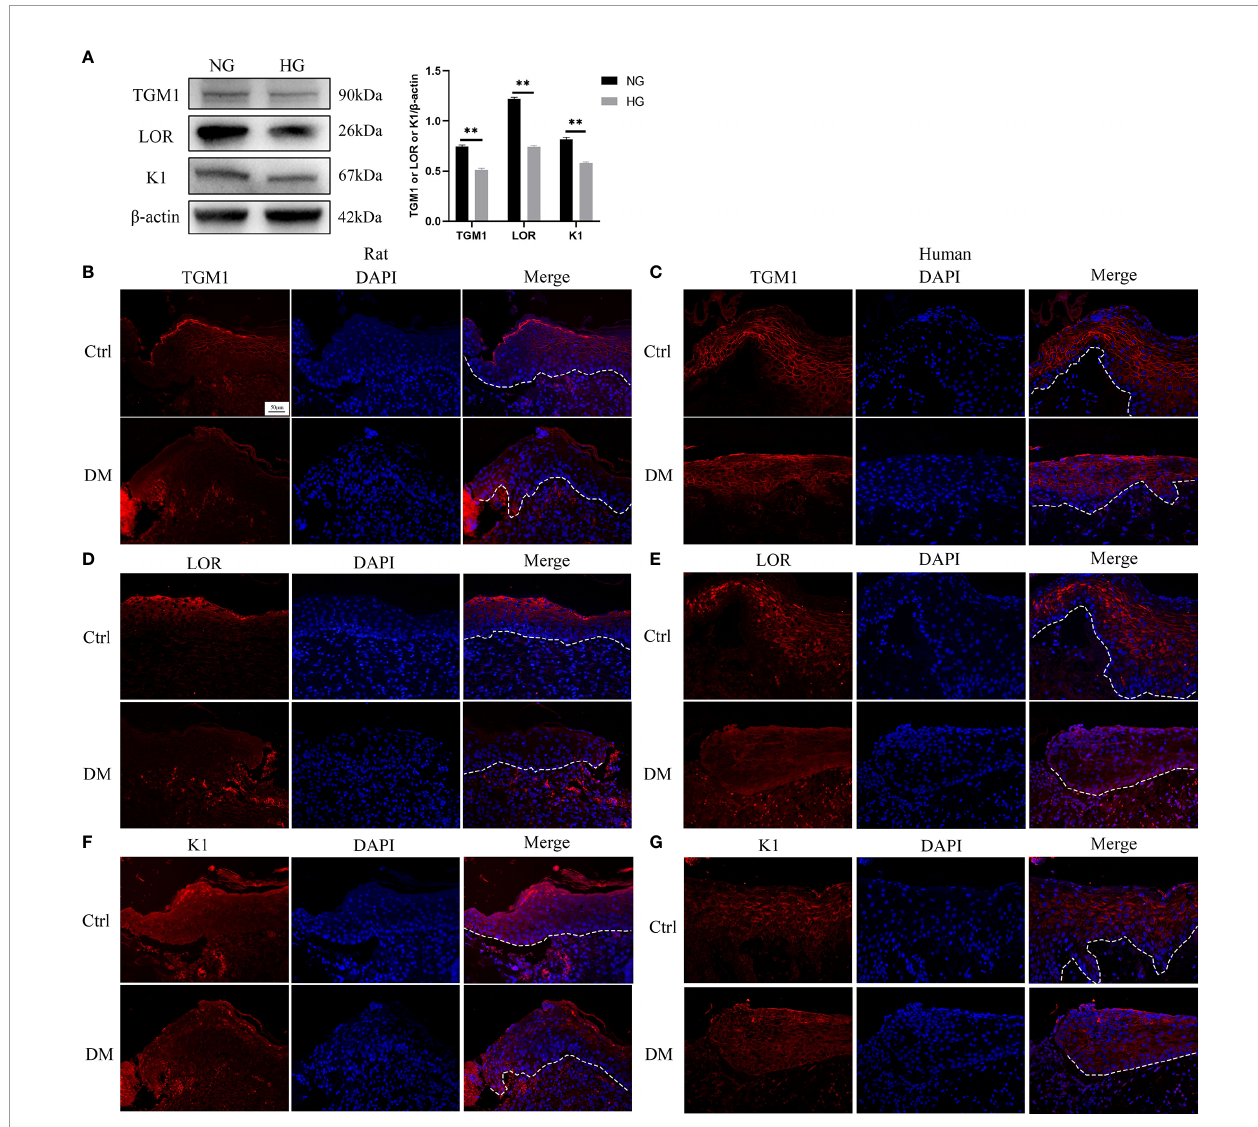
FIGURE 1 | High glucose or diabetes impairs HaCaT or keratinocytes differentiation. (A) The expression levels of differentiation makers such as TGM1, LOR, and K1 were analyzed by western blot. (B – G) TGM1, LOR, and K1 expression levels were determined by immuno fl uorescence assay in wound margin tissues of rats (B, D, F) or humans (C, E, G) . The nuclei were stained blue using DAPI. Magni fi cation: ×200, Scale bar = 50 m m. The white dotted line represents the epidermis- dermis dividing line. Data were shown as the mean ± SEM measured in triplicate from three independent experiments. ** P <